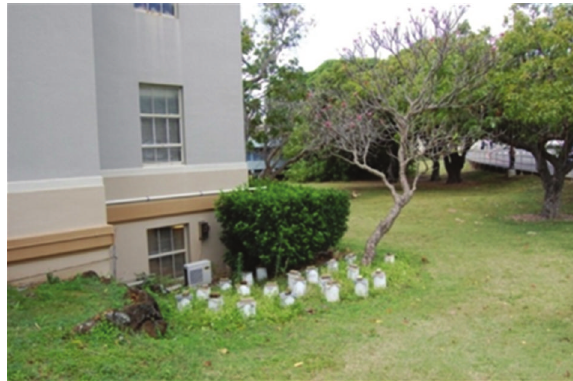
Figure 3: Coptotermes formosanus field site near Miller Hall, University of Hawaii at Manoa, Oahu,